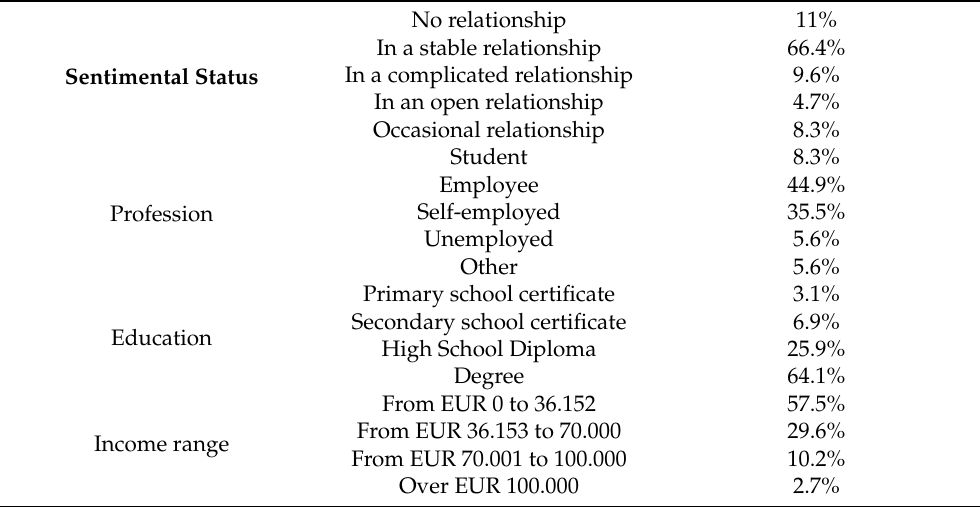
Table 1. Sociodemographic characteristics of the sample.